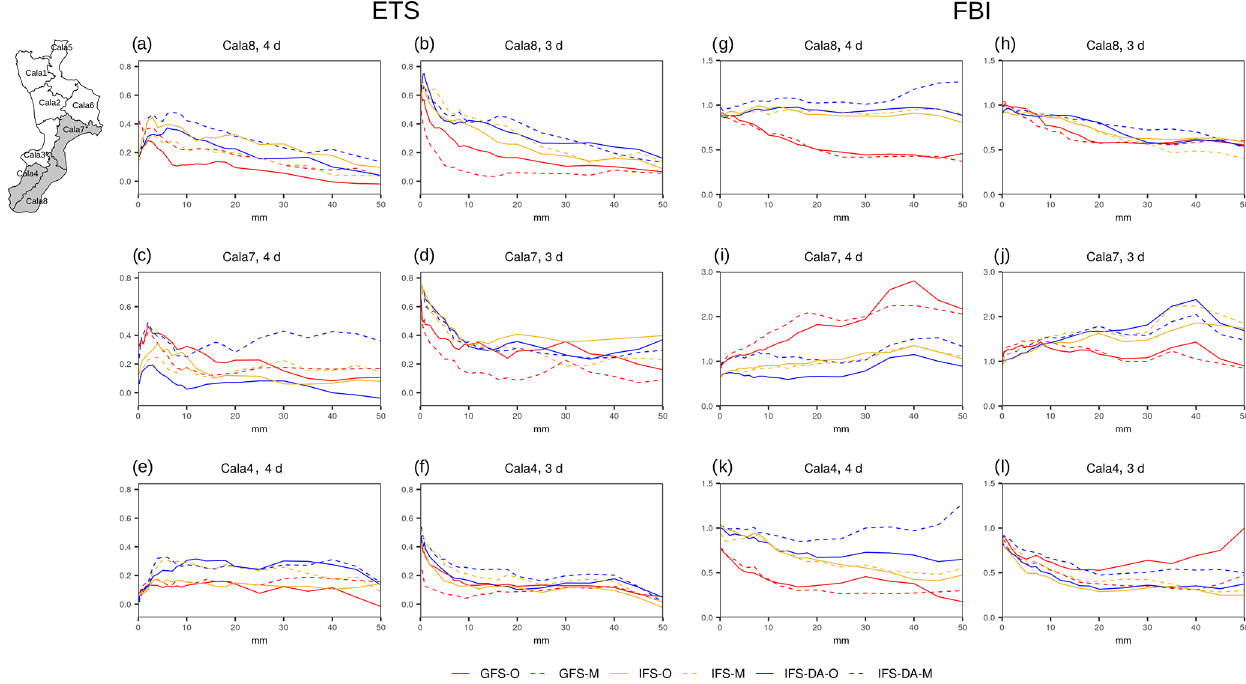
Figure 12. Categorical scores ETS (equitable threat score) (a–f) and FBI (frequency bias index) (g–l) calculated on the rain gauges located in the three civil protection warning areas more affected by the event from case study 2 (highlighted as grey areas on the map in the top left) for both the 4 and the 3d period.